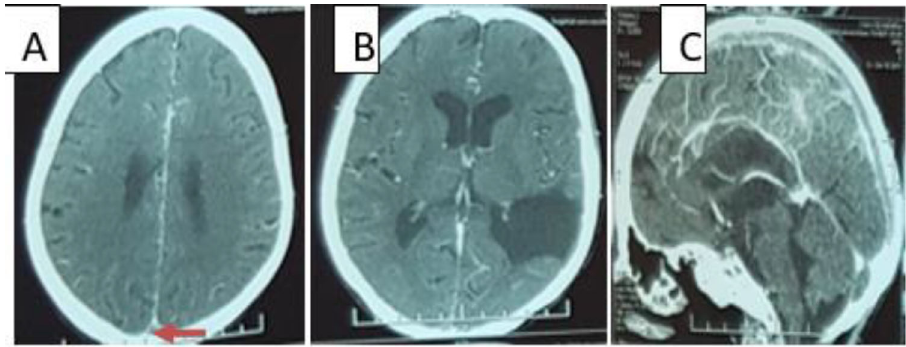
Figure 1. Cerebral CT scan (A, B: axial plane, C: Sagittal plane) showing a venous thrombosis of superior sagittal sinus (A, C) and a left temporoparietal porencephalic cyst